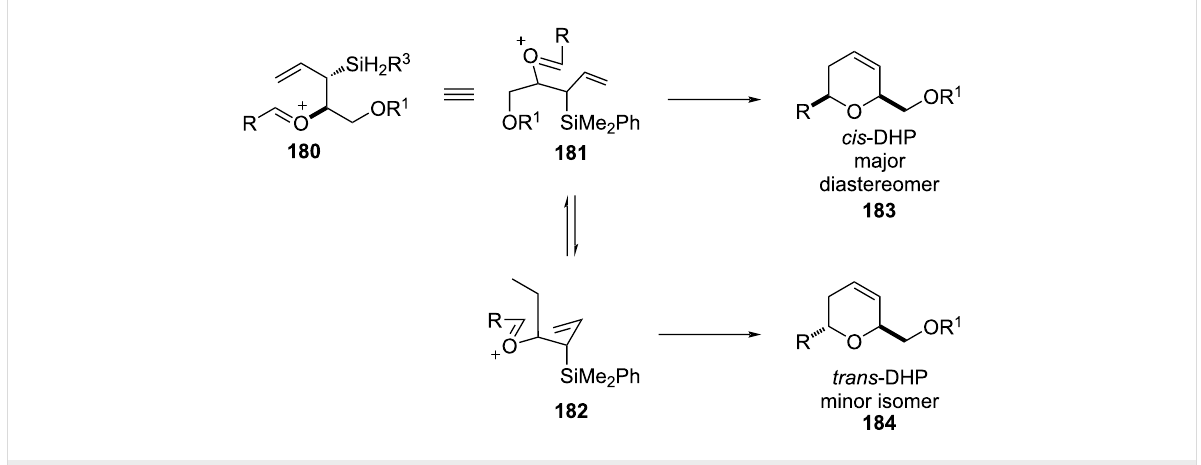
Scheme 44: Roush and co-workers’ [4 + 2]-annulation strategy for DHP synthesis [82].